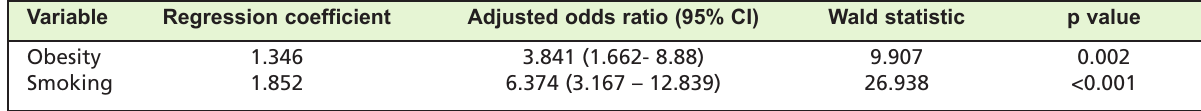
Table II: Risks factors and outcome in patients with orthopaedic SSI by multiple logistic